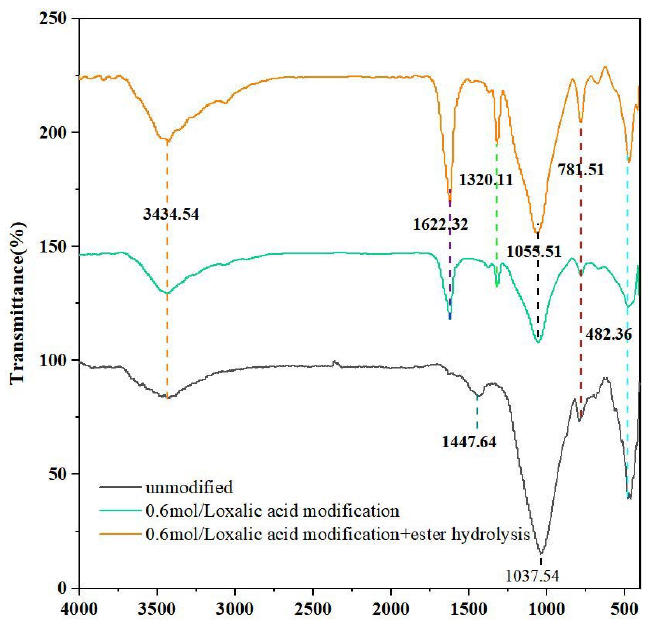
Figure 6. Fourier transformation infrared spectroscopy under different modification conditions.